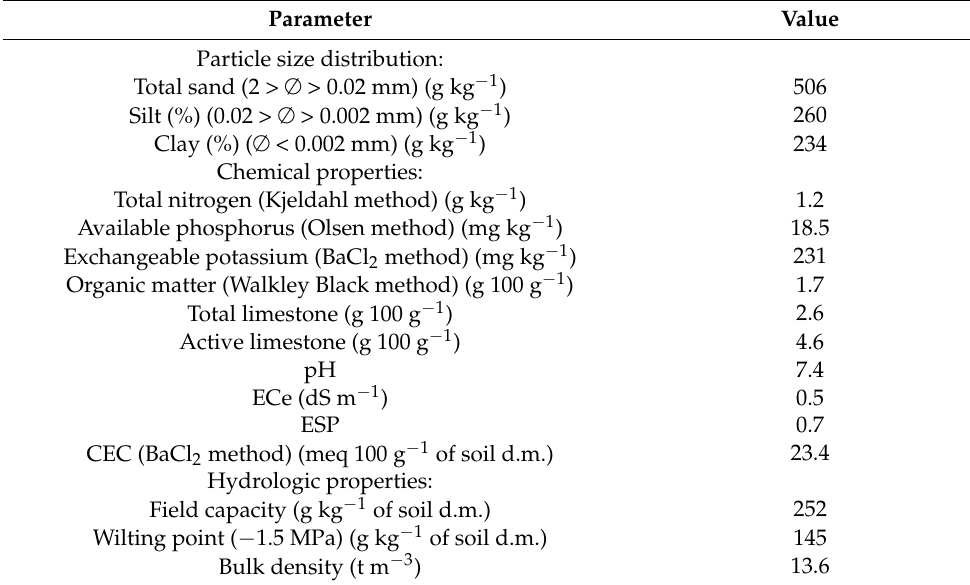
Table 5. Particle size distribution, chemical properties, and hydrologic properties of the soil used in the trials. Parameter Value Particle size distribution: